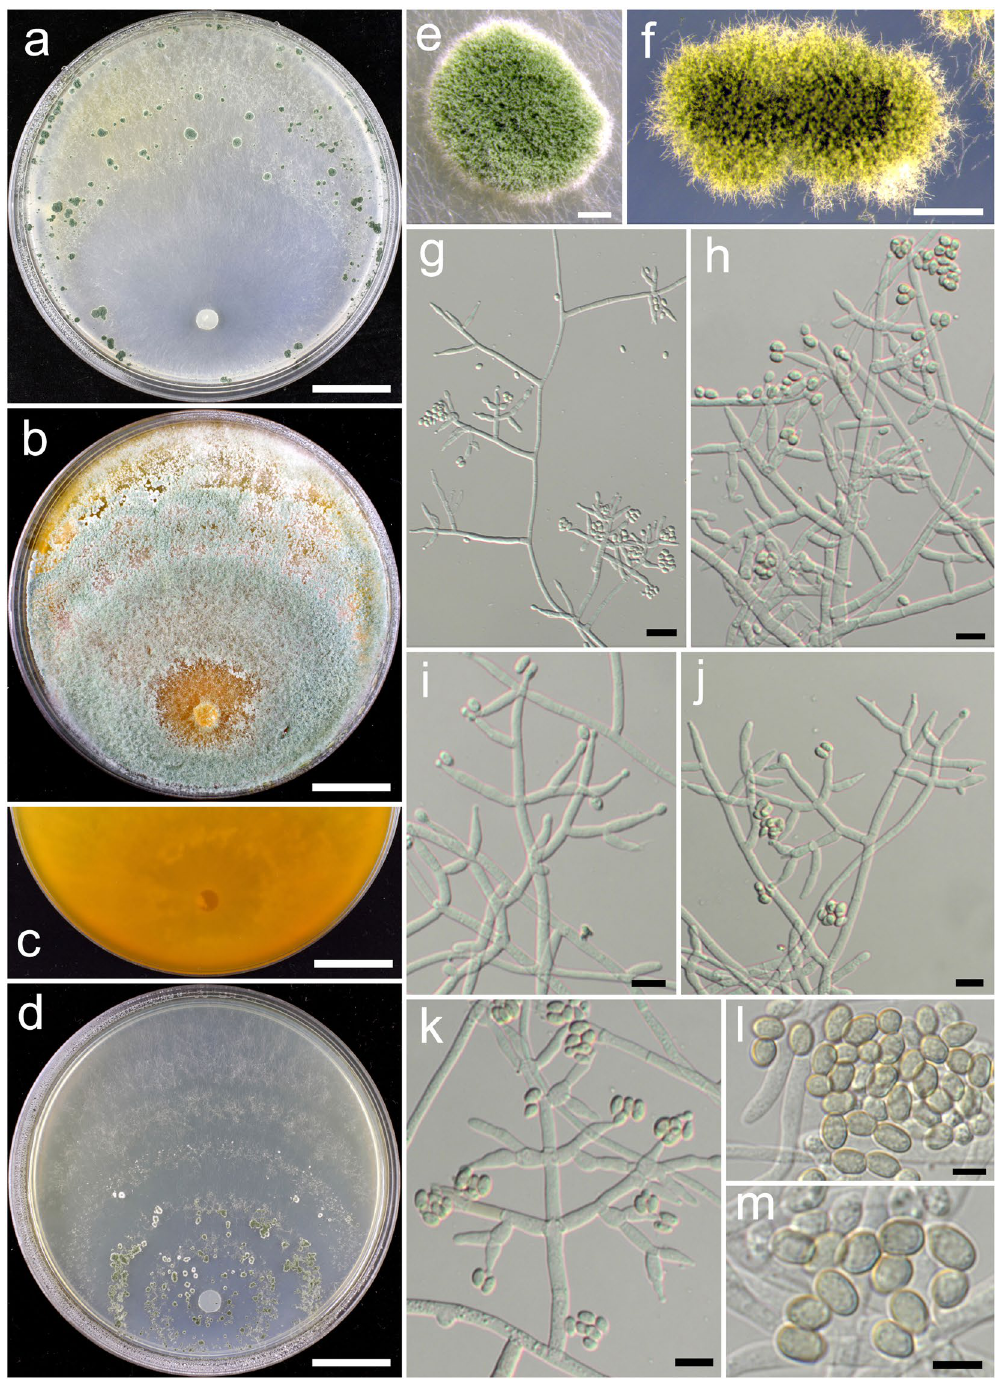
Figure 14. Trichoderma hunanense (HMAS 248841). ( a – d ) Cultures at 25 °C, 7 d (a. on CMD; b. on PDA; c. on PDA, reverse; d. on SNA); ( e , f ) Conidial pustules (e. CMD, 7 d; f. SNA, 7 d); ( g – k ) Conidiophores and phialides (PDA, 4 d); ( l – m ) Conidia (CMD, 4 d). Bars: a–d = 20 mm. e = 600 μ m. f = 800 μ m. g = 20 μ m. h–k = 10 μ m. l–m = 5 μ